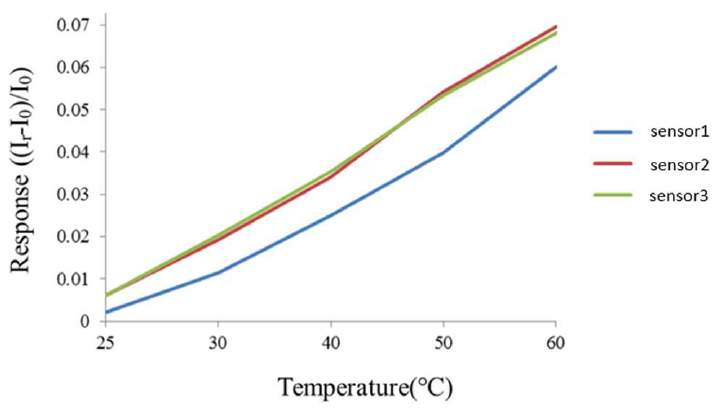
Figure 3. Correction curve of the micro temperature sensor.